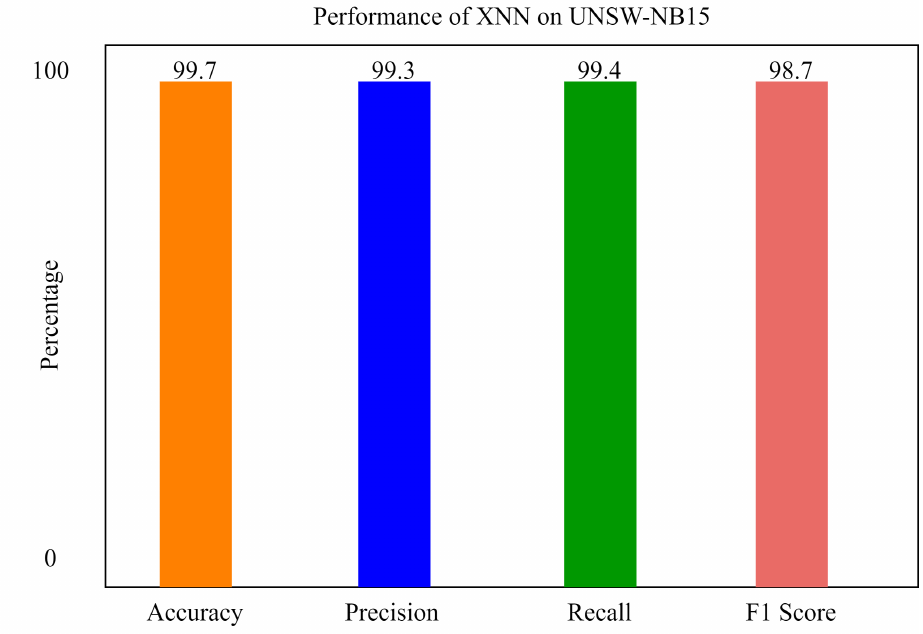
Figure 8. The performance of xNN on